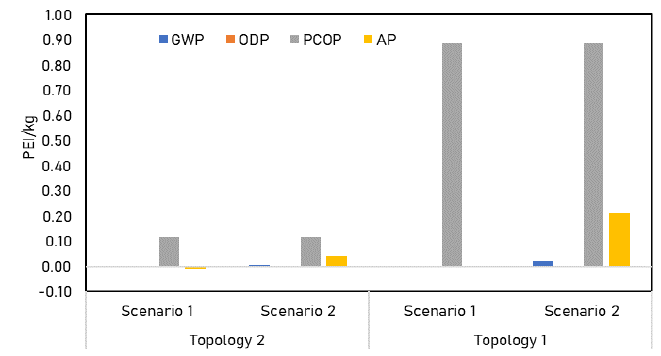
Figure 14. Generation rates of potential environmental impact (PEI) for atmospheric categories.